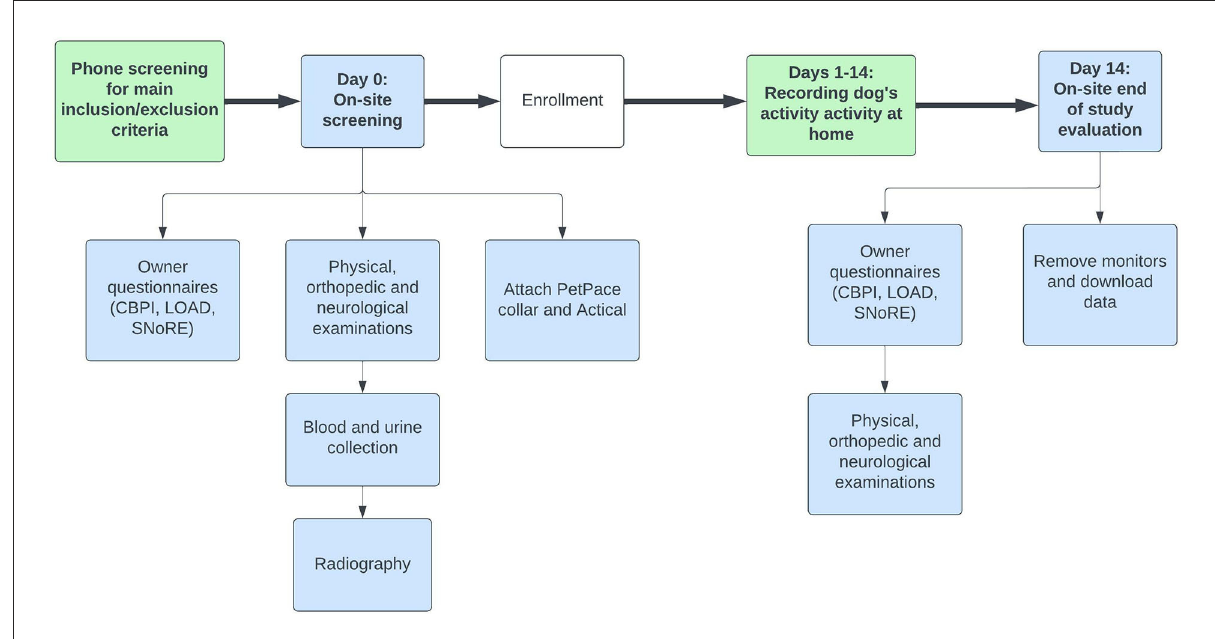
FIGURE1 Schematic diagram showing study timeline and